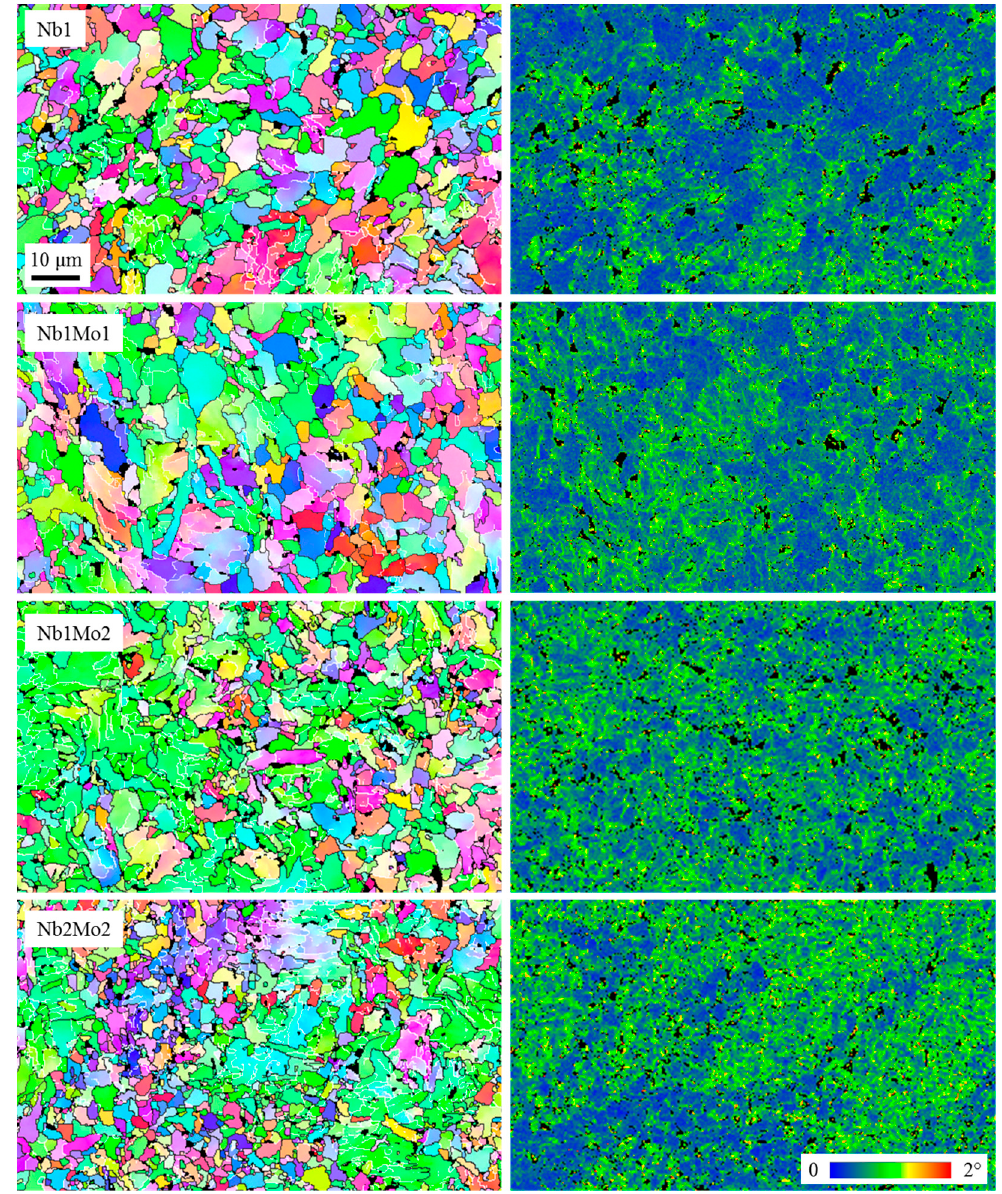
Figure 6. EBSD IPF maps (left row) and kernel average misorientation (KAM) maps (right row) of the investigated steels Nb1, Nb1Mo1, Nb1Mo2, Nb2Mo2 (top to bottom) for the as-quenched conditions (high angle grain boundaries (HAGB) in dark grey and low angle grain boundaries (LAGB) in white, martensite and retained austenite (M/A) in black).